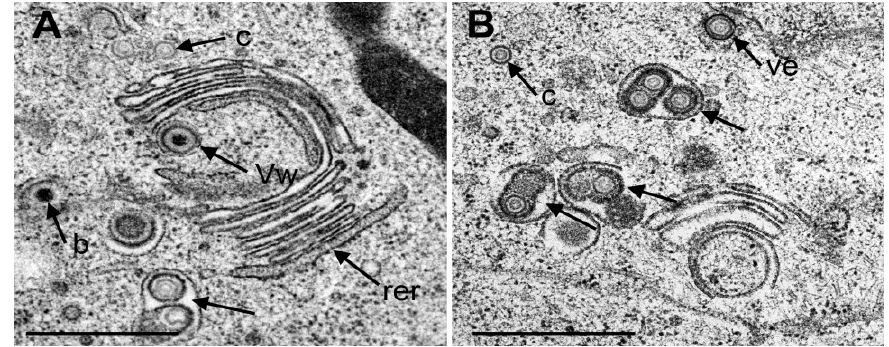
Figure 7. TEM images of Golgi fields in Vero cells at 12 hpi with wt HSV-1(A) and at 20 hpi (B) with the repair mutant R2641. ( A ) Close to a large Golgi stack is a virion in a concentric vacuole (Vw) derived by wrapping. Typically, the space between viral envelope and vacuolar membrane is similar in electron density as the tegument. In contrast, the space between viral envelope and membrane of vacuoles or Golgi cisternae containing one or more virions (arrow) derived either by budding into it or by intraluminal transportation from the RER. The space between virions and vacuolar membrane is electron lucent. (c) capsids, (b) budding capsid. Note that the outermost membrane of the Golgi stack shows the characteristic of RER membranes (rer) indicating connectivity between Golgi complex and RER. ( B ) Three vacuoles or Golgi cisternae (arrows) close to a small Golgi stack contain virions derived by budding or by intraluminal transportation. One virion is in the RER (Ve), and one capsid in the cytoplasm. Bar = 500 nm.